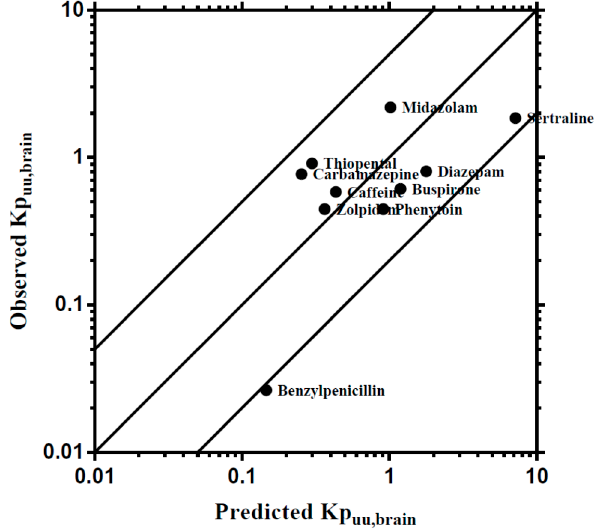
Figure 3. Comparisons of predicted and reported Kp uu,brain in rat. The solid bold mid-line represents the line of unity, and solid outer lines represent 5-fold prediction error.